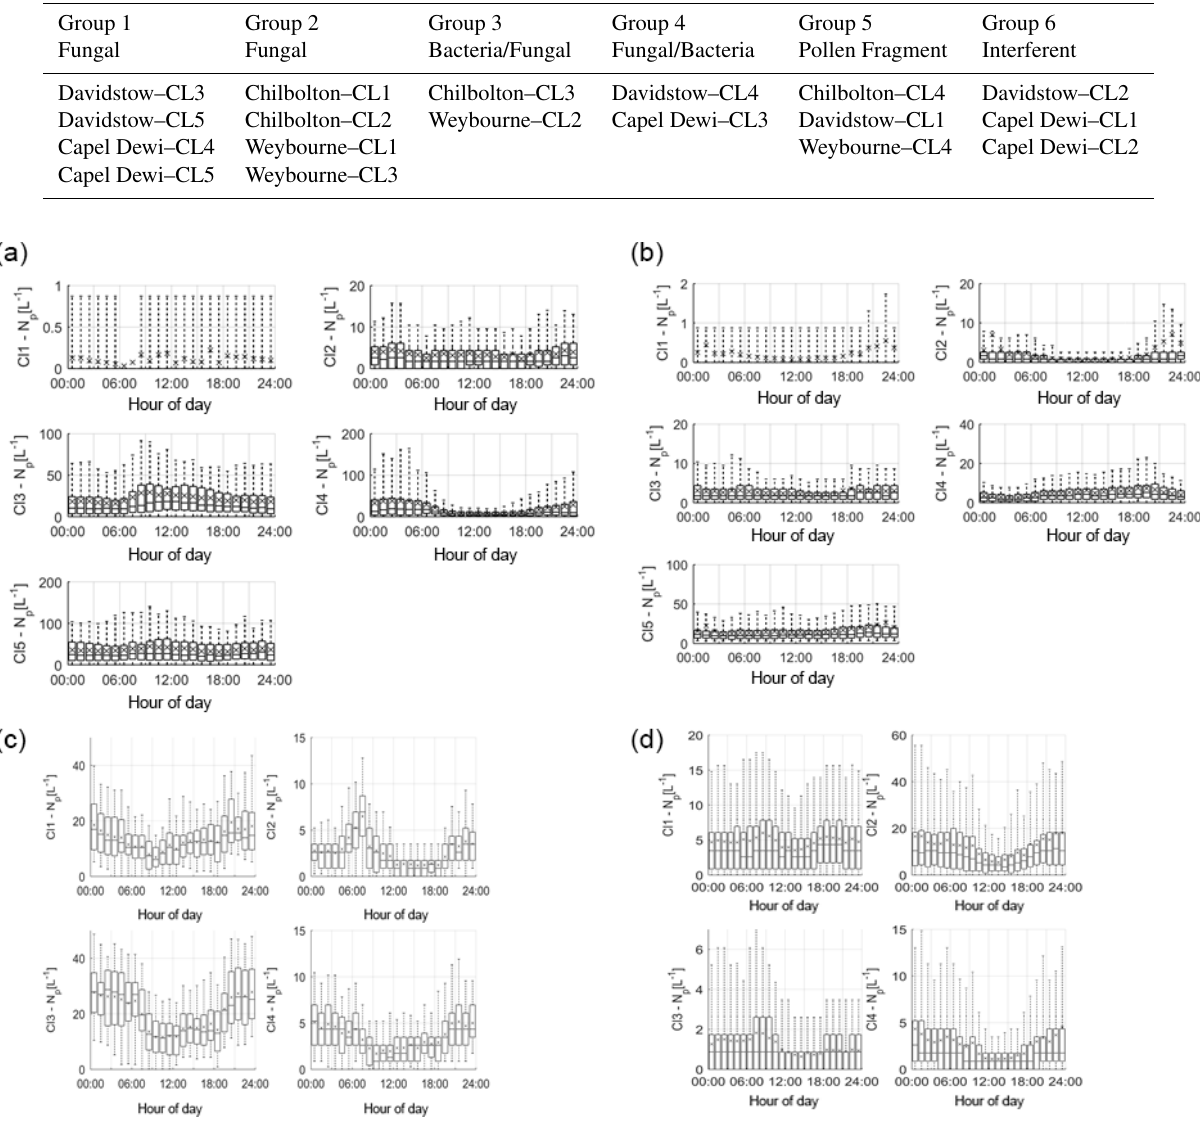
The trend is similar for both Chilbolton and Weybourne Cluster 4, in which there is a drop in concentrations dur- ing the morning, with lower concentrations during the day, which then increase in the evening. This illustrates that these are fungal spores, unlike Davidstow Cluster 1, which shows more variation during the day. Considering this, it is possi- ble that only Davidstow Cluster 1 is a pollen fragment, and Chilbolton and Davidstow Cluster 4 are both fungal spores. This potentially illustrates that the dominance of channel FL2, when accompanied by a high signal in channel FL3, is what separates pollen from fungal